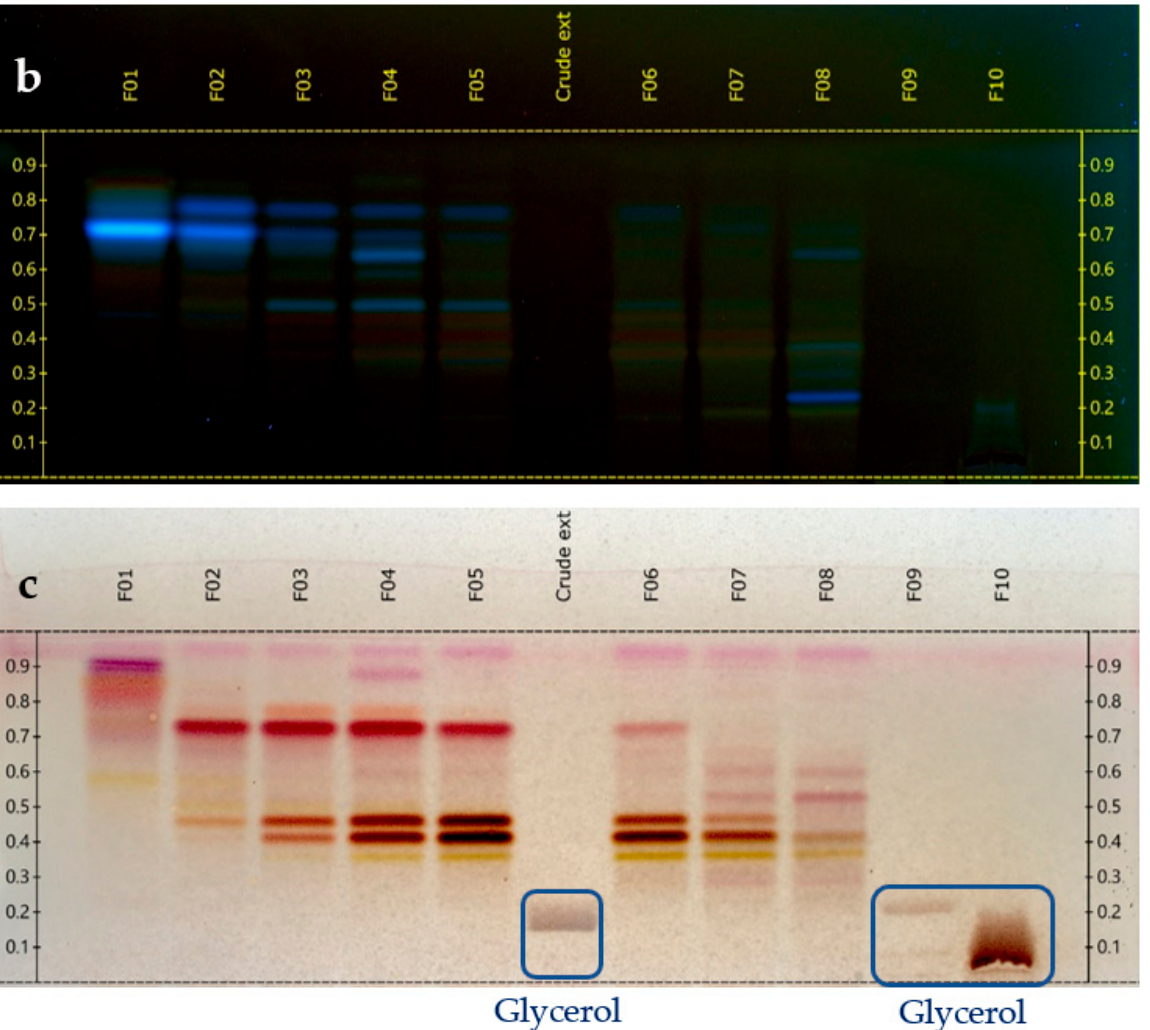
Figure 1. TLC profile of the 10 CPC fractions. ( a ) 254 nm; ( b ) 366 nm; and ( c ) visible after vanillin/H 2 SO 4 reagent spraying and heating.